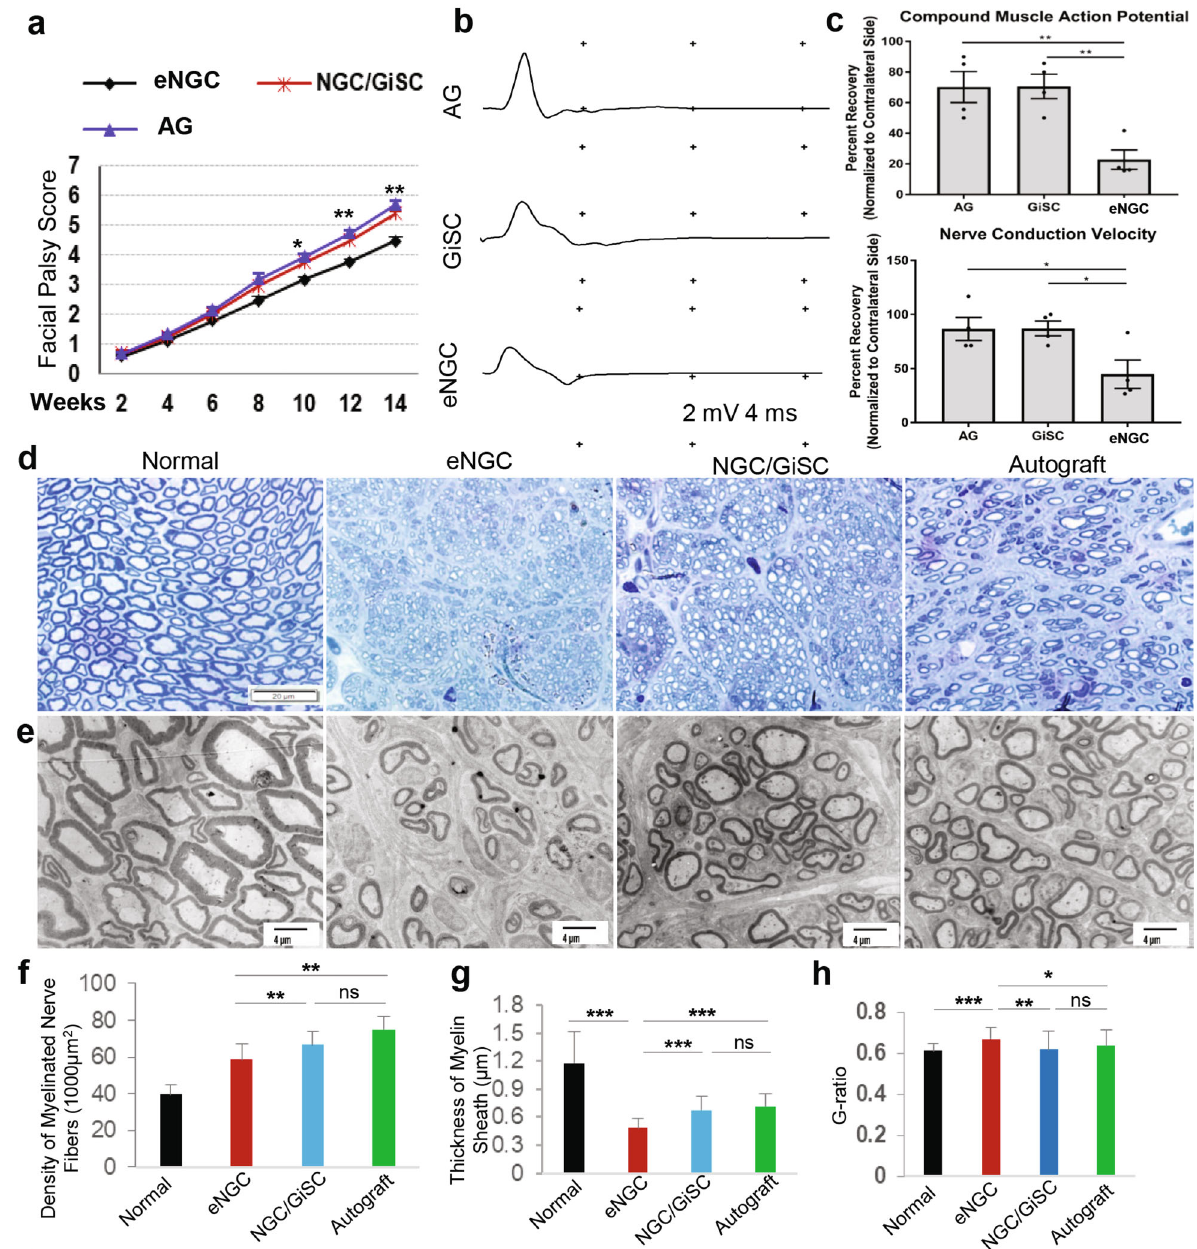
Fig. 8 Implantation of NGC/GiSCs promotes functional recovery and axonal regeneration of transected rat facial nerves. a Longitudinal evaluation of facial palsy score in rats following implantation of empty nerve conduits (eNGC), nerve autograft (AG), or nerve conduits (NGC) laden with GiSCs for up to 14 weeks. Data represent the mean ± SD ( n = 6 rats). * p < 0.05, ** p < 0.01 (NGC/GiSC vs eNGC). Student ’ s two-tailed unpaired t -test ( a ). b , c Compound muscle action potential (CMAP) recordings of the vibrisal muscles of both the injury side and the contralateral normal side of rats following both proximal and distal stimulation. Motor nerve conduction velocity of both the injury side and the contralateral normal side of rats was calculated as described in “ Methods ” . Data represent the mean ± SD ( n = 4 rats). * p < 0.05, ** p < 0.01. One-way ANOVA with the Tukey ’ s post test ( c ). d Toluidine blue staining of semi-thin sections of the newly regenerated facial nerves from different groups of rats at 14 weeks post-injury and implantation. Scale bar = 20 µm. e Transmission electron microscopy (TEM) of ultrathin sections of the newly regenerated facial nerves from different groups of rats at 14 weeks post-injury and implantation. Scale bars, 4 µm. f Quanti fi cation of density of myelinated axons (the number of myelinated axons/1000 µm 2 ). g Quanti fi cation of the thickness of the myelin sheaths. h Calculation of the G-ratios (the inner axonal diameter/the outer myelinated fi ber diameter). Data represent the mean ± SD ( n = 3 rats). * p < 0.05, ** p < 0.01, *** p < 0.001; ns no signi fi cance. One-way ANOVA with the Tukey ’ s post test ( f − h ). AG autograft; eNGC empty nerve conduit; NGC nerve conduit; GiSC GMSC-derived NCSC/SCP-like (PNI) due to our limited understanding of the pathophysiology of precursors and their derivatives could be harnessed to convert PNI and mechanisms underlying nerve repair/regeneration. adult NC-derived cells, e.g., GMSCs, toward their precursor state. Currently, nerve autografts remain the gold standard for the To date, there is still lack of ef fi cient therapies that ensure full treatment of injured nerves with a gap, but major shortcomings regeneration and functional recovery of peripheral nerve injury